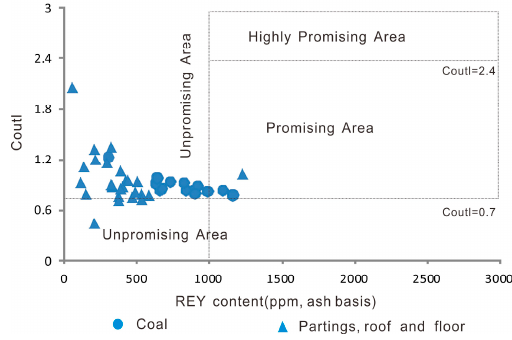
Figure 12. Evaluation of REY in the coal ashes and host rocks in the Zhongliangshan Coalfield. The classification base map is based on Dai et al. [9].